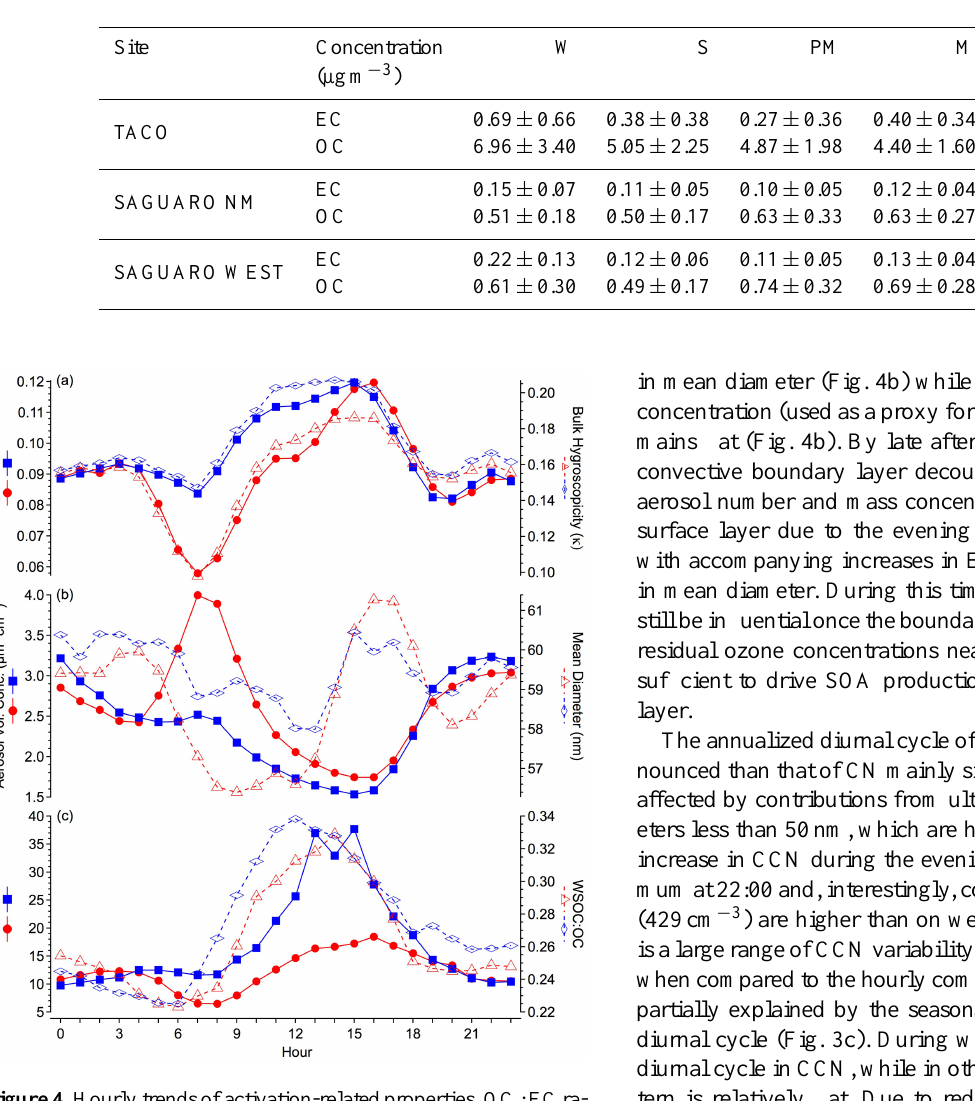
Figure 4. Hourly trends of activation-related properties, OC:EC ra- tio, and WSOC:OC ratio for weekdays (red) and weekends (blue). Note the applicability of the OC:EC ratio starts to become less well defined on weekends above 25, since EC concentrations are typi- cally below limit of detection